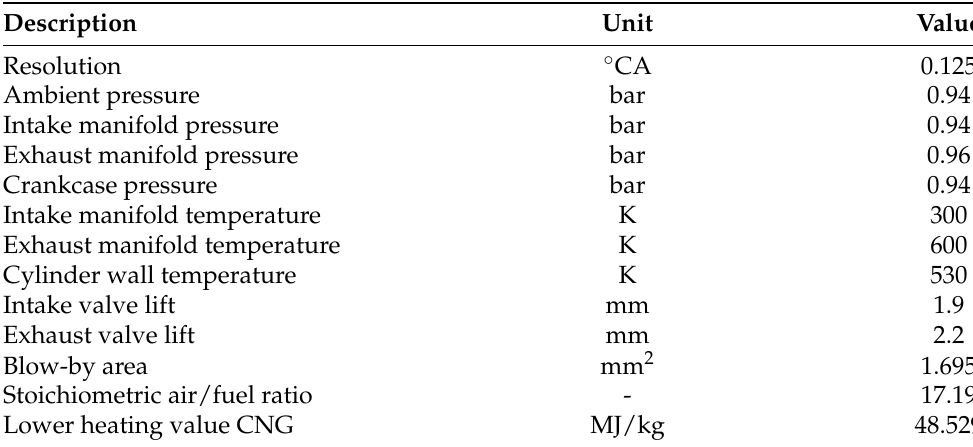
Table 2. Constants applied in the process